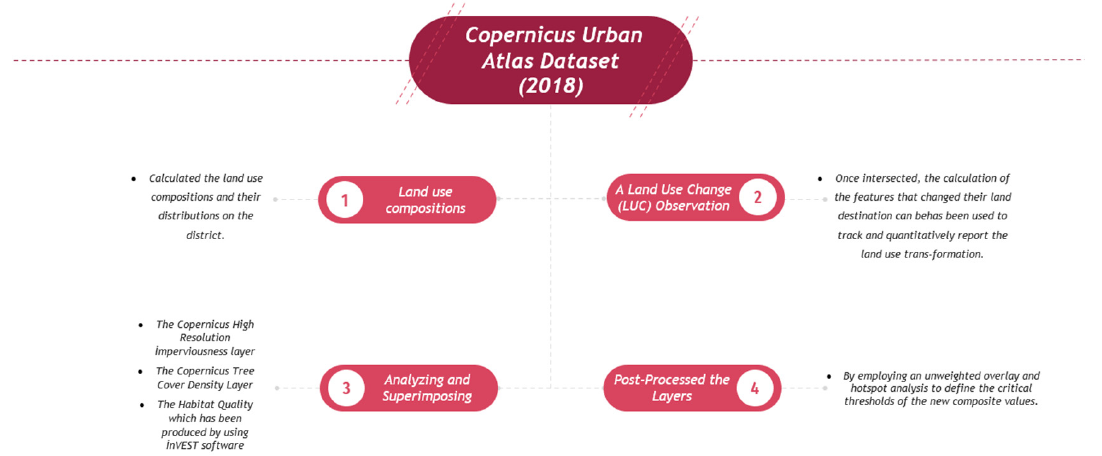
Figure 2. Analytical workflow of the GIS processing phases (source: author’s elaboration).